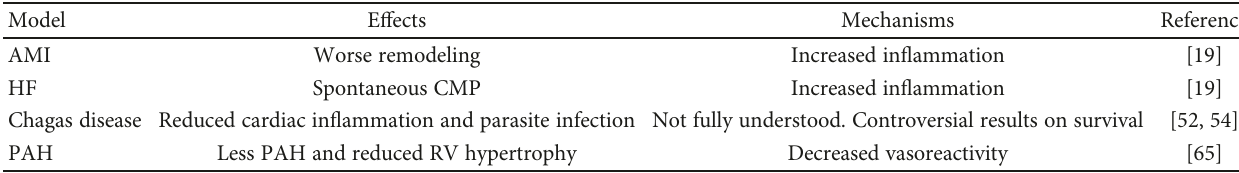
Table 1: Preclinical models of cardiovascular disease in Lgals1 − / − mice.